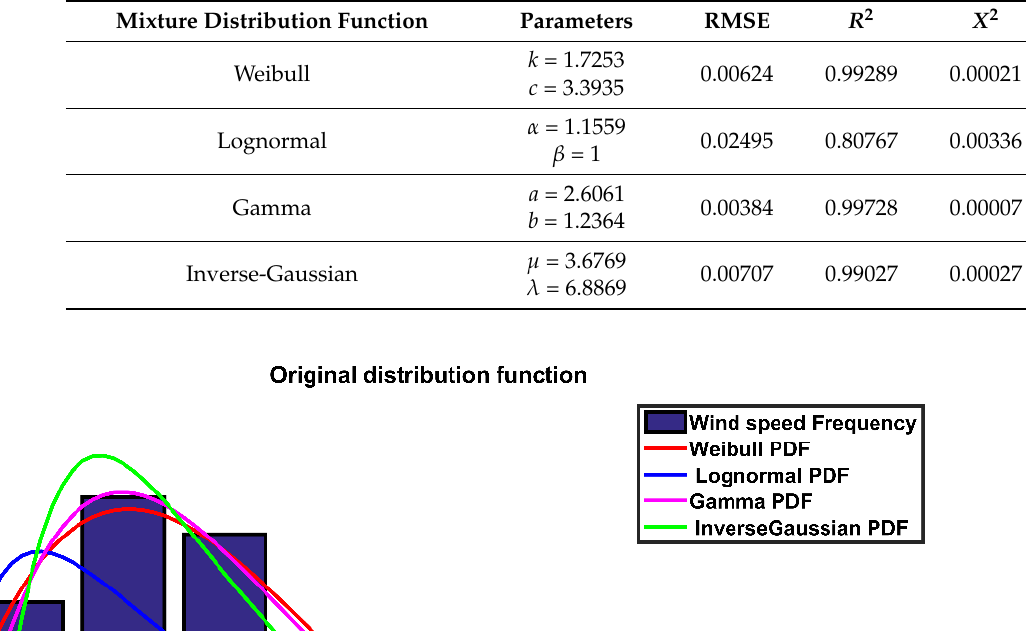
Table 1. The probability distribution parameters for original PDFs in wind speed modeling.